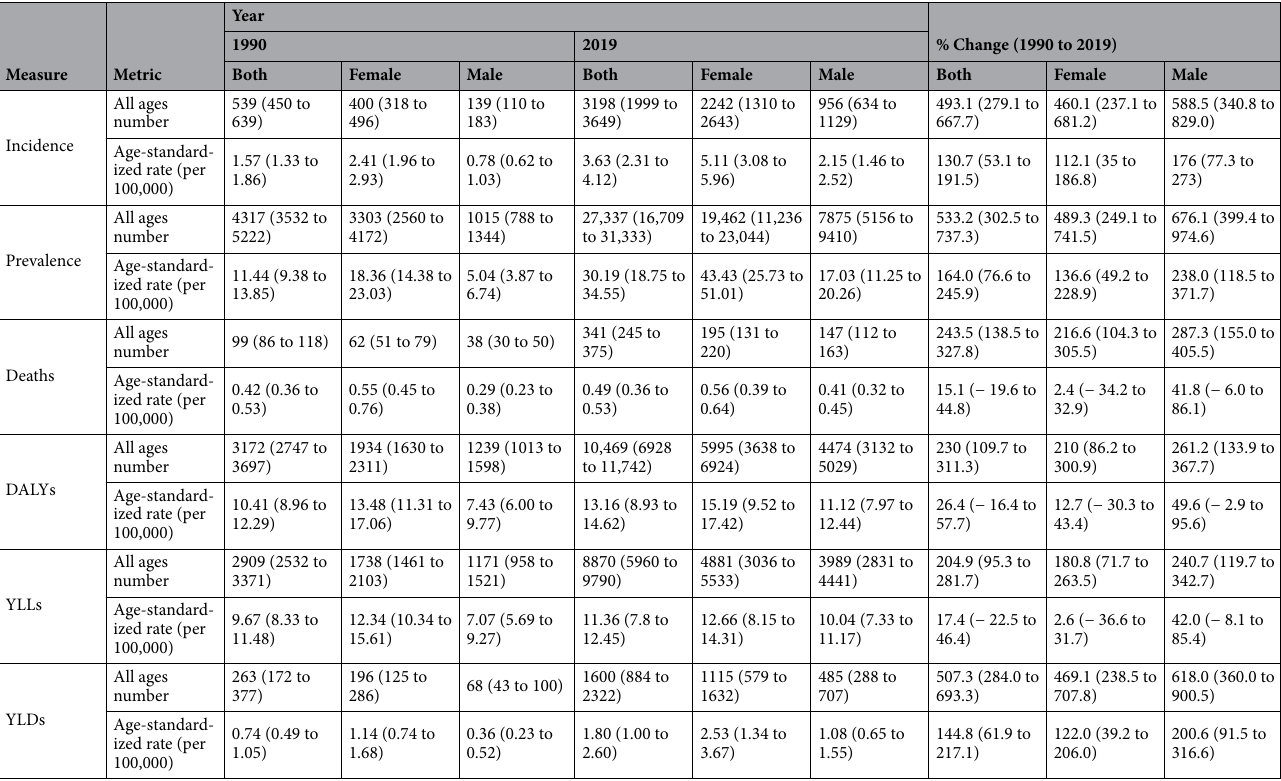
Table 1. Burden measures by all ages number and age-standardized rate (per 100,000) by sex in 1990 and 2019 with percent change (%) between 1990 and 2019, Iran. Data in parentheses are 95% Uncertainty